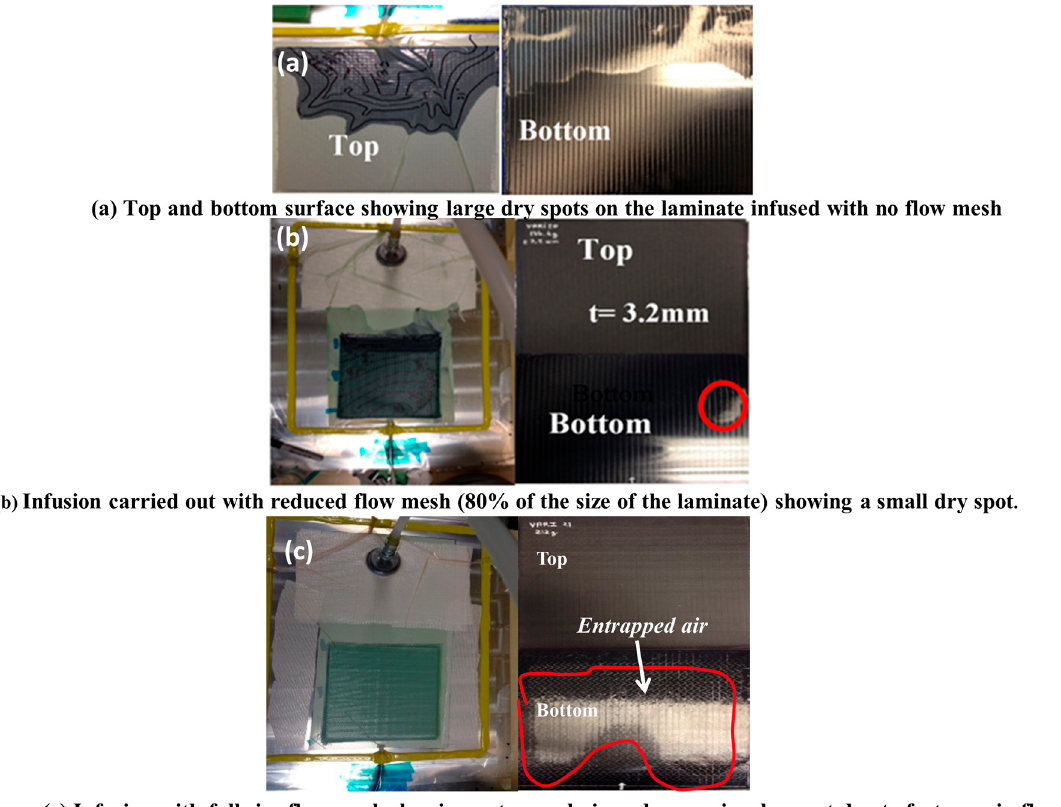
Figure 7. Evolution of VARI process optimisation with different flow mesh length. ( a ) No flow mesh; ( b ) 80 % flow mesh; ( c ) full size flow mesh.